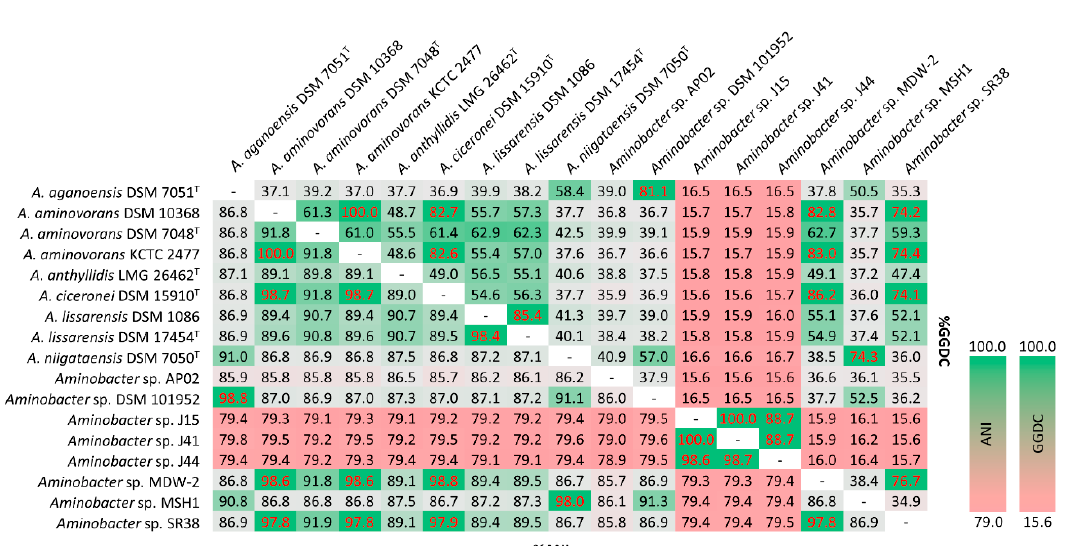
Figure 2. (a) Whole-genome phylogeny of the 17 Aminobacter strains, including all type strains of validly published species. M. loti DSM 2626 T was used as an outgroup. The branch lengths are scaled in terms of GBDP distance formula d ₅ . Filled circles at the nodes are GBDP pseudo-bootstrap support values > 70% from 100 replications. The scale bar indicates the number of substitutions per variable site. Each colored box contains Aminobacter members belonging to the same species, according to ANI and GGDC values (Figure 3); type strains are in bold. (b) Black sectored circles denote the presence and degree of completeness of genes involved in the metabolic pathways shown on top of the figure (each gene accounts for 1/22 sector for methylamine oxidation; 1/11 sector for serine cycle; 1/9 sector for CODH form I). White circles denote the complete absence of genes involved in the pathway.